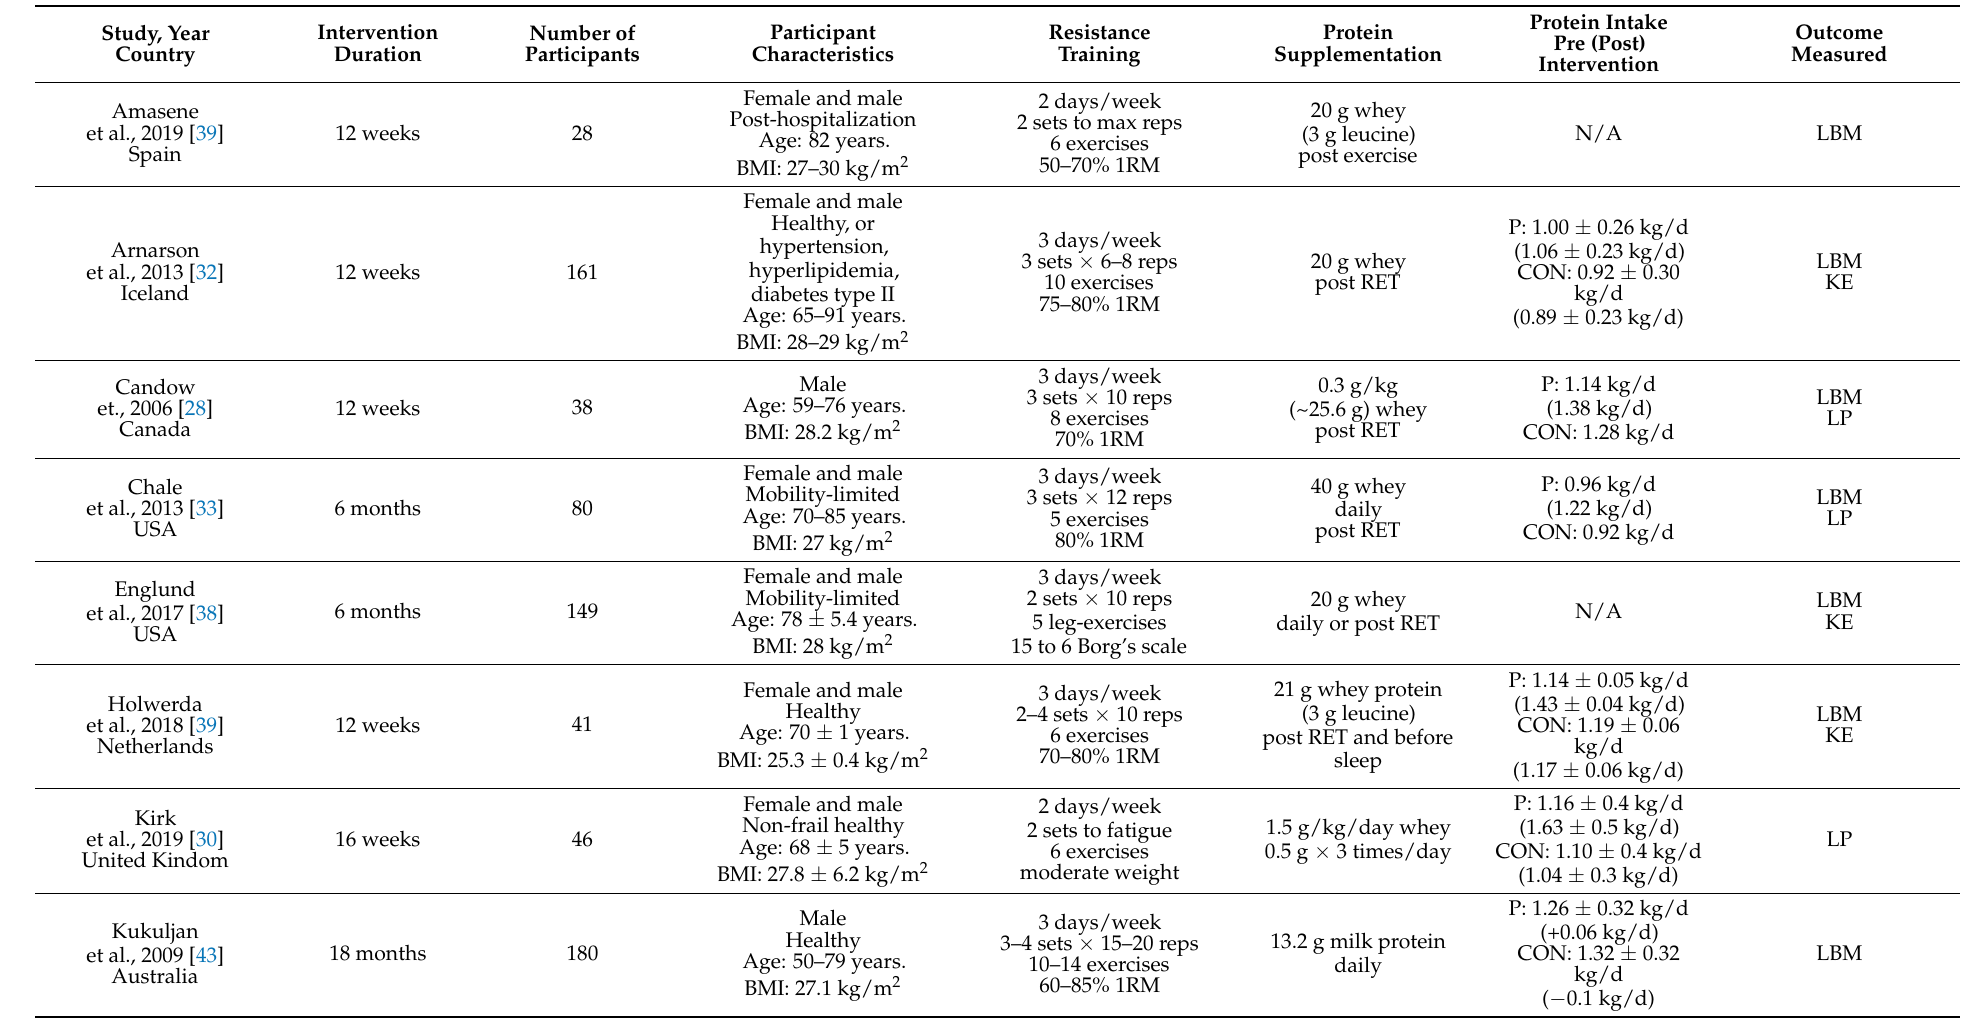
Table 1. Characteristics of the intervention